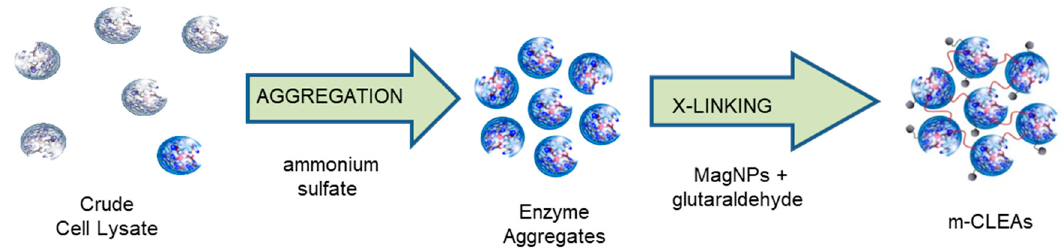
Figure 12. Preparation of magnetic CLEAs.